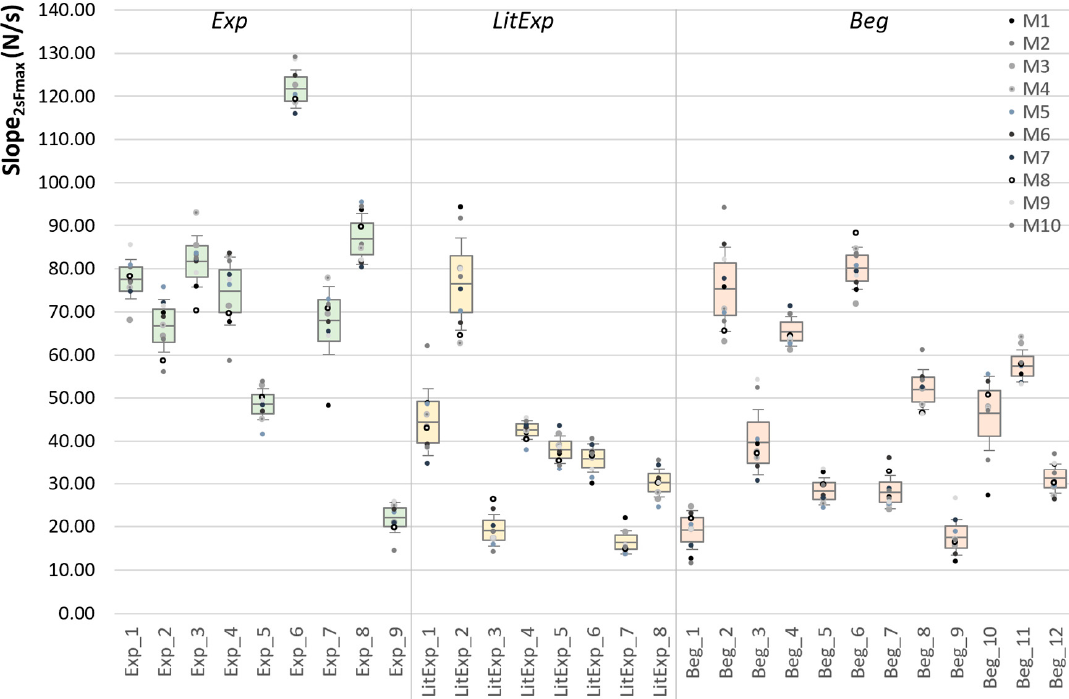
Table 3. Inter-group comparisons of force parameters, normalized mean Euclidean distance (MED) and intraclass correlation coefficient (ICC(3,1)). Arithmetic means (M), standard deviations (SD), coefficients of variation (CV) and statistical results of Kruskal–Wallis test (Chi-square ( χ 2 ), significance p ) for group comparisons between experienced (Exp), little experienced (LitExp) and beginners (Beg) of the parameters starting force (M_F start , (N)), maximum force (M_F max , (N)), ratio of F start to F max (%), ICC(3,1) and MED (%). For significant results, the pairwise comparisons of Dunn– Bonferroni post-hoc test are given by z-values, adjusted p -values (p adj ) and effect sizes r.